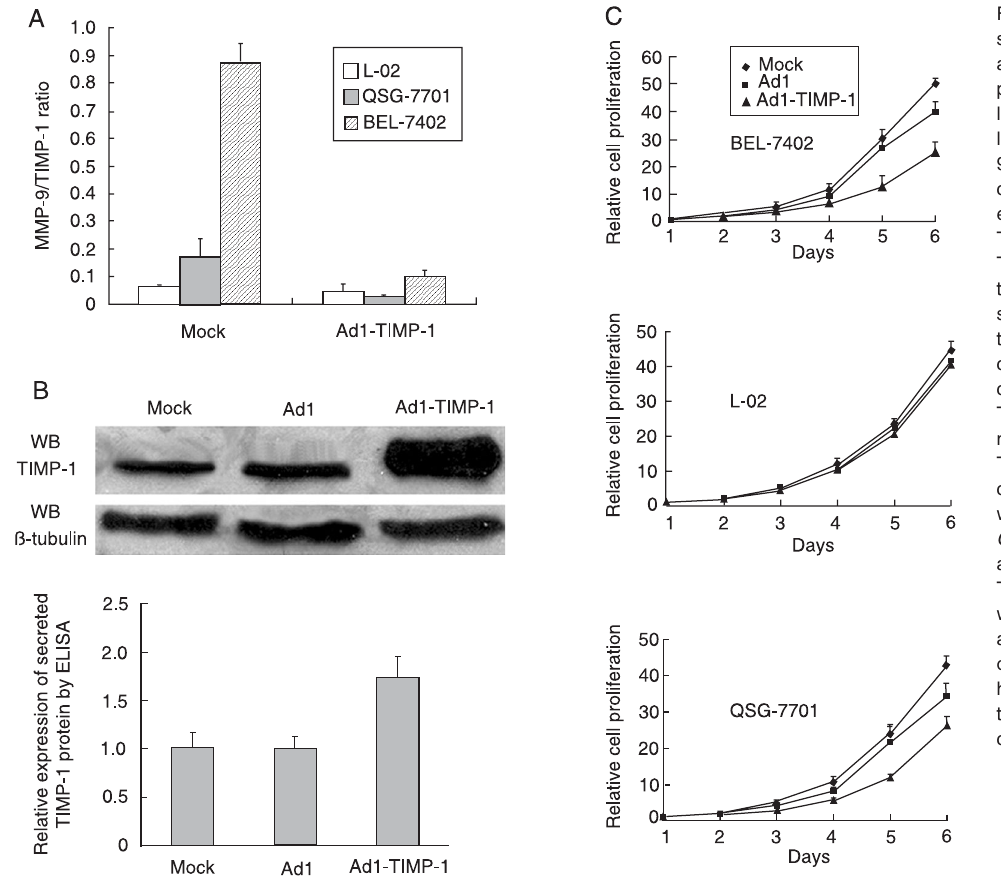
Figure 1. Overexpression of tis- sue inhibitor of metalloprotein- ases (TIMP-1) could inhibit the proliferation of the hepatocellu- lar carcinoma BEL-7402 cell line. A , Comparison of the MMP- 9/TIMP-1 ratio in three different cell lines with recombinant ad- enovirus carrying TIMP-1 (Ad1- TIMP-1) and without (mock) TIMP-1 overexpression. B , De- tection of TIMP-1 overexpres- sion in BEL-7402. Western blot- ting (WB) analysis was pro- cessed with ß-tubulin as internal control. The active protein of TIMP-1 secreted in the culture medium was detected by ELISA. The mock here indicated the cells without any treatment which was an internal control. C , Inhibition of BEL-7402, L-02 and QSG-7701 proliferation by TIMP-1. The cells were infected with Ad1-TIMP-1, Ad1 control and mock control. The number of cells was counted daily with a hemocytometer after trypsiniza- tion and the growth curves were